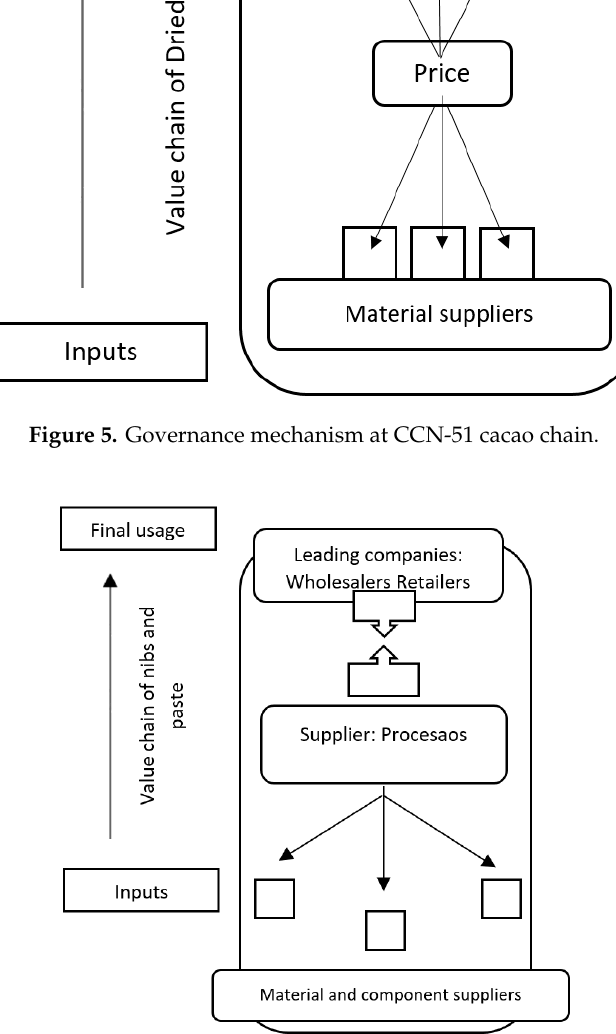
Figure 6. Governance mechanism at Arriba chain.